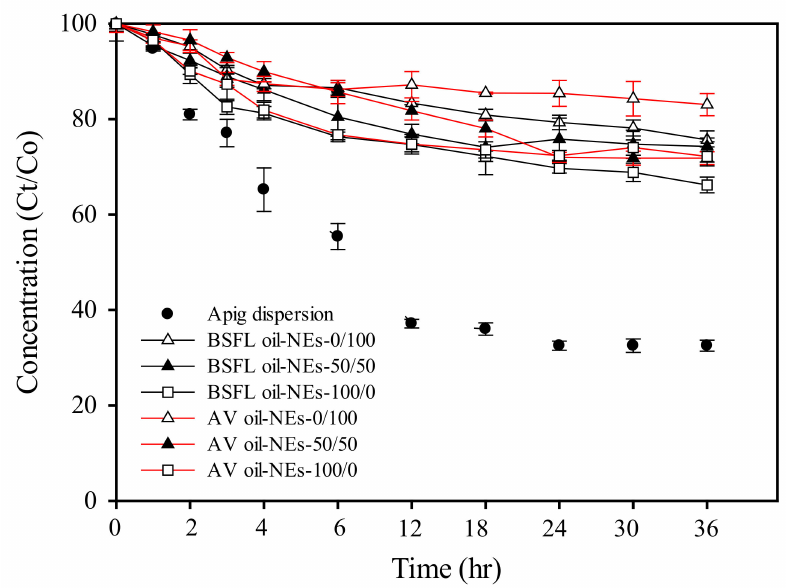
Figure 3. Chemical storage stability of Apig incorporated into BSFL oil NEs and AV oil NEs with SOR 60%, oil content 1%, and different surfactant ratios of HL to